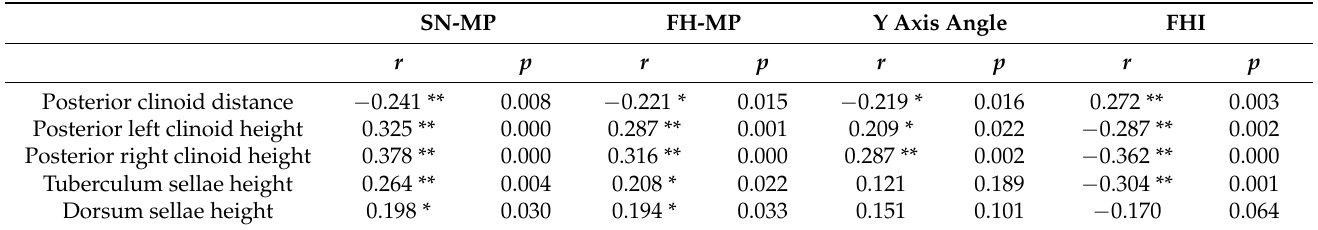
Table 5. Correlation between sella turcica dimensions and cephalometric